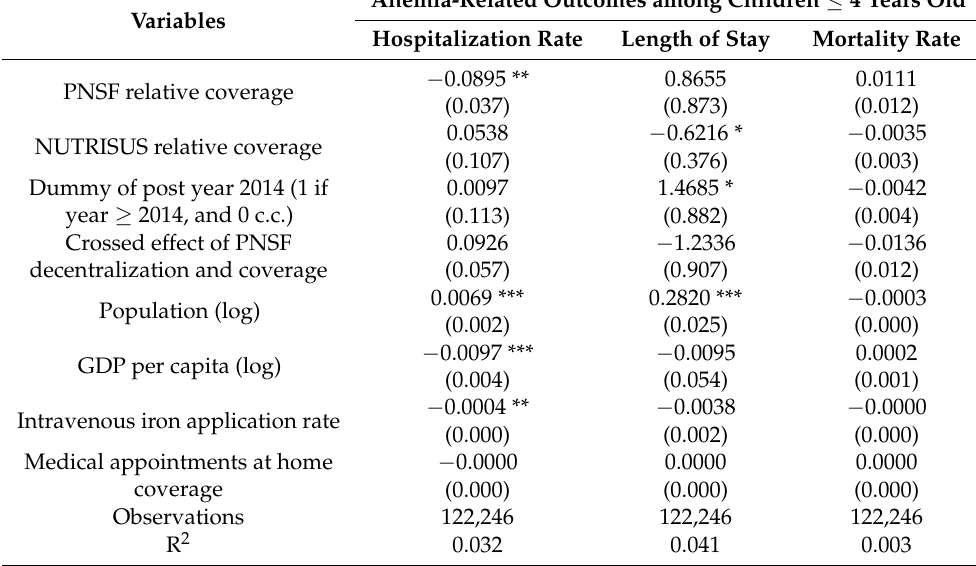
Table 3. Coefficients of the DD–OLS estimates on the effects of the PNSF and NutriSUS on anemia- related outcomes among children, Brazil, 1998–2019.